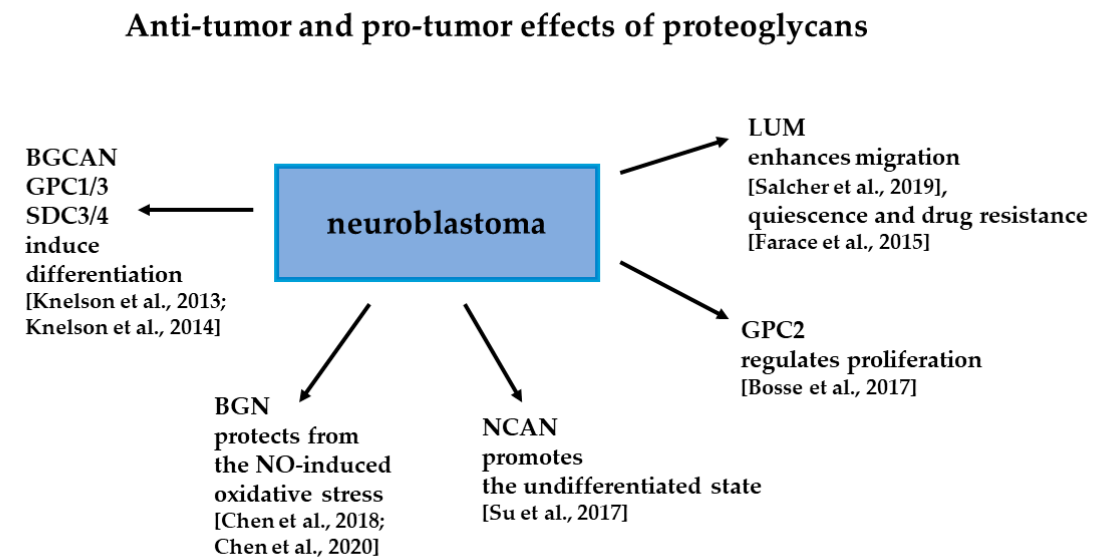
Figure 1. Anti-tumor and pro-tumor effects of selected proteoglycans in NB (see Section 3 for more detail) [50,51,53,54,56,62,65,66].